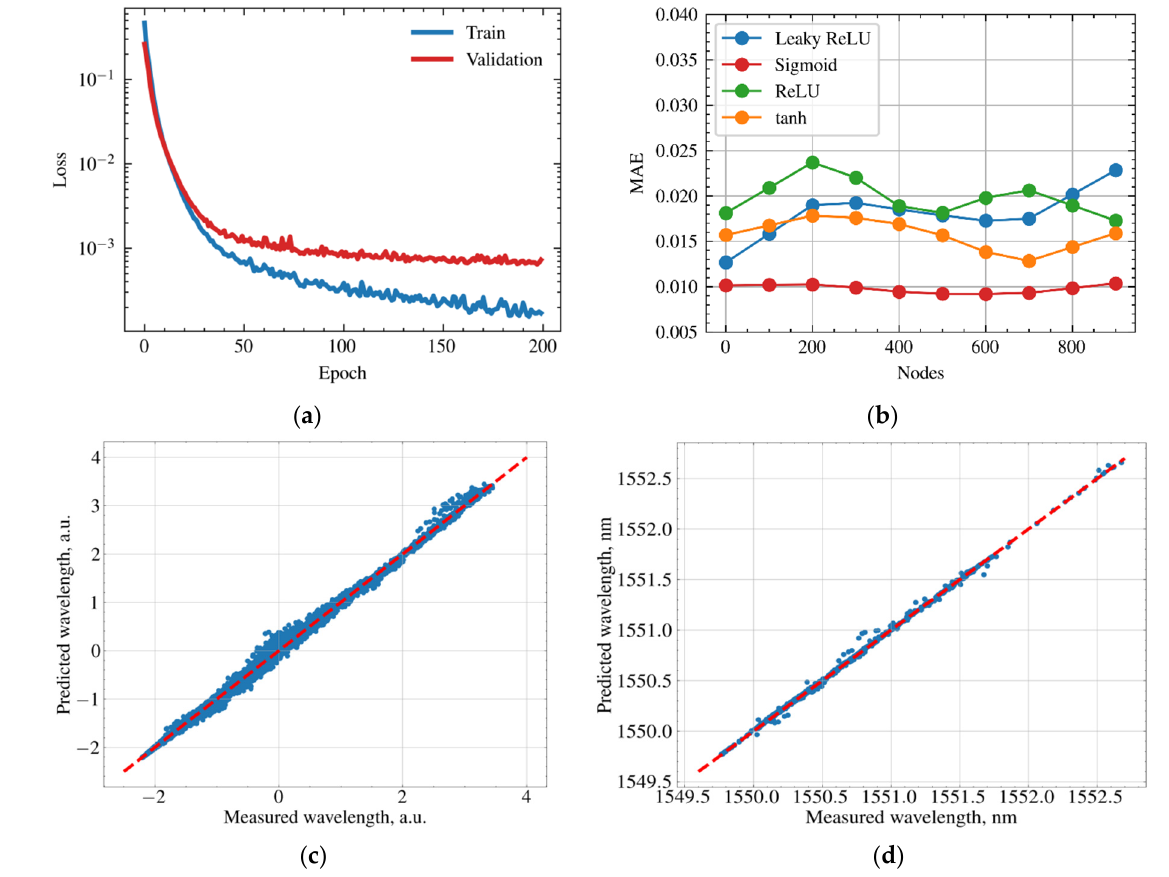
Figure 9. Performance of the CNN ( a ) Learning curve of the model on training dataset and evolution of the loss function of validation dataset. ( b ) Mean absolute error of CNN for different activation functions and different number of nodes of the fully connected layers. ( c ) Predicted reflectance peak positions of the FBGs of the sparse sensors against measured values at normalized scales. ( d ) Predicted positions of the reflectance peak for single FBG of sparse sensor against measured value.